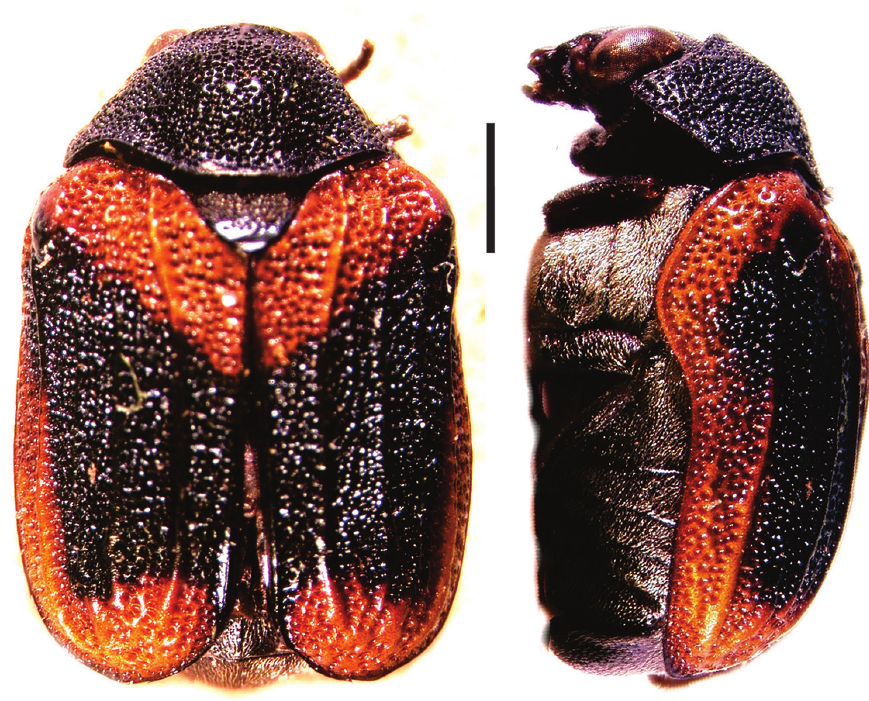
Figure 4. Aratea costata Lacordaire (1) , left: habitus (dorsal view), right: habitus (lateral view). Distribution. Only two species from Brazil, one present in Argentina, likely to also occur in